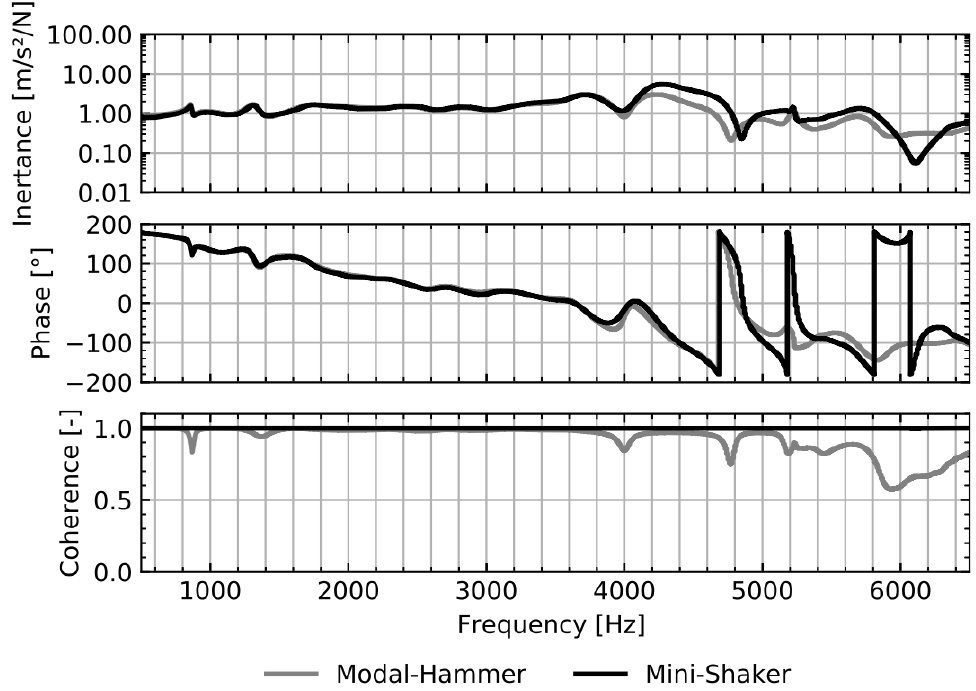
Figure 5. Inertance, phase, and coherence of the hammer and shaker excitation at 0° position in tangential reaction direc- tion.